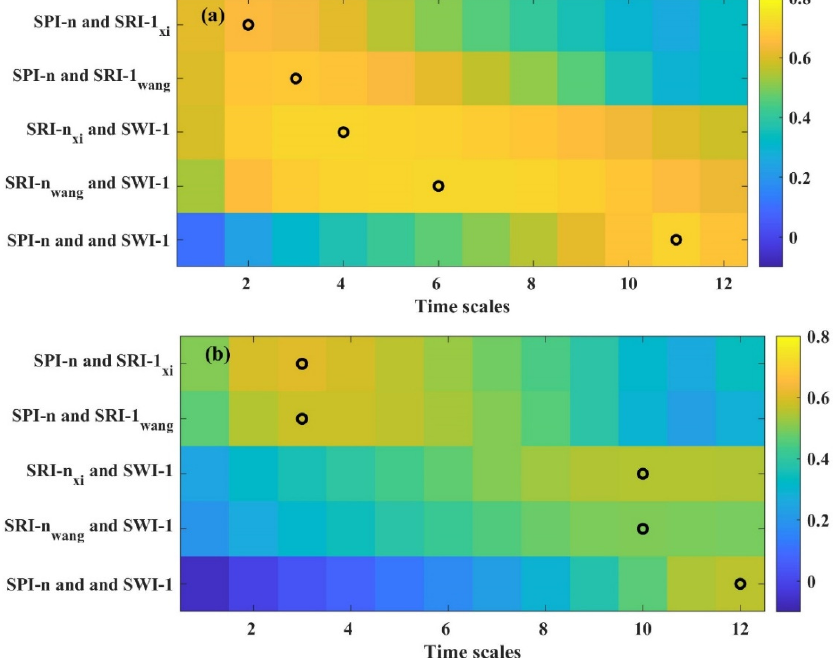
Figure 10. Correlation coefficients between the meteorological drought and hydrological drought series at various timescales: ( a ) before a changing environment and ( b ) after a changing environment in the study area. Black circles show the locations of the most suitable propagation time.